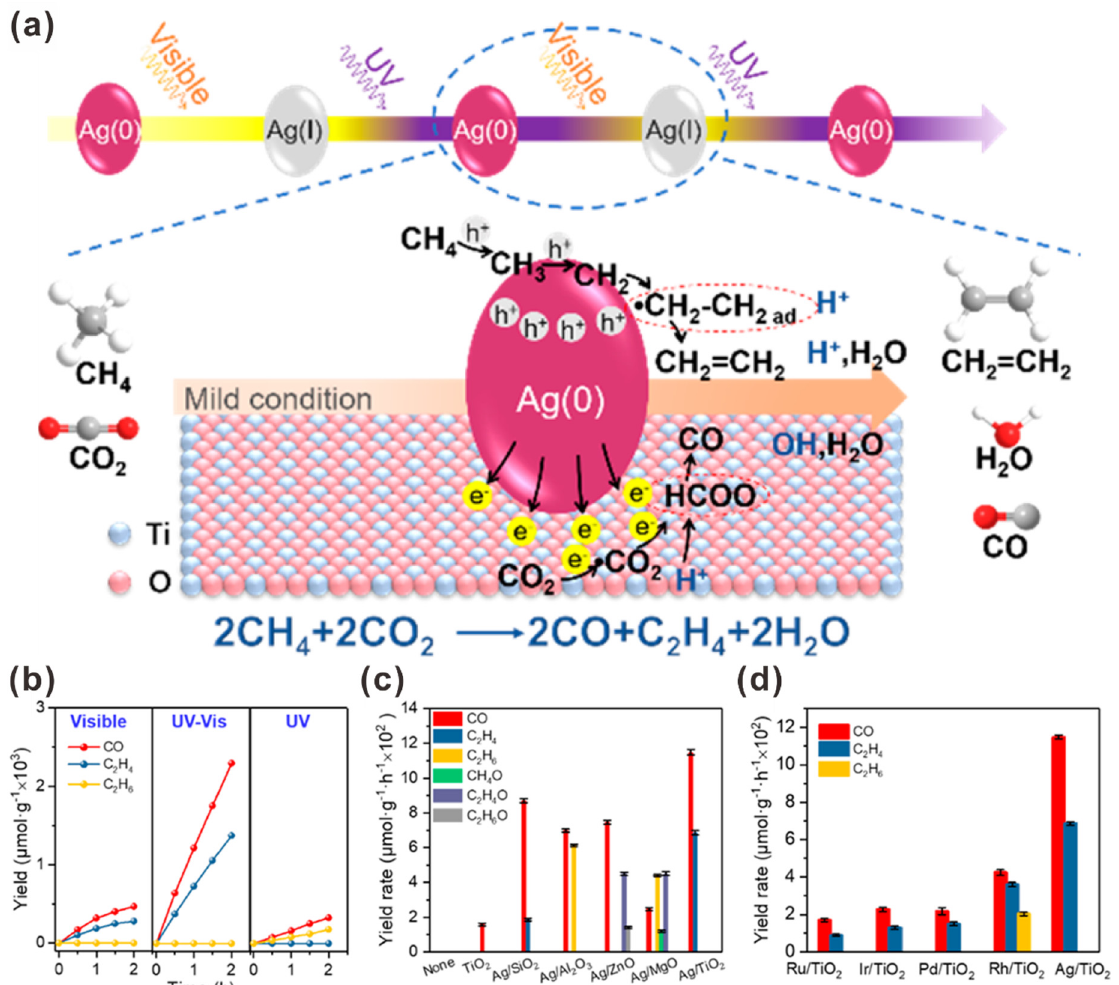
Figure 6. ( a ) Schematic illustration of Ag/TiO 2 for photocatalysis of CH 4 and CO 2 into ethylene and the photocatalytic performance depending on ( b ) the light source, ( c ) primary photocatalyst, and ( d ) metal cocatalyst. Reproduced with permission from Reference [83]. Copyright 2019 American Chemical Society.